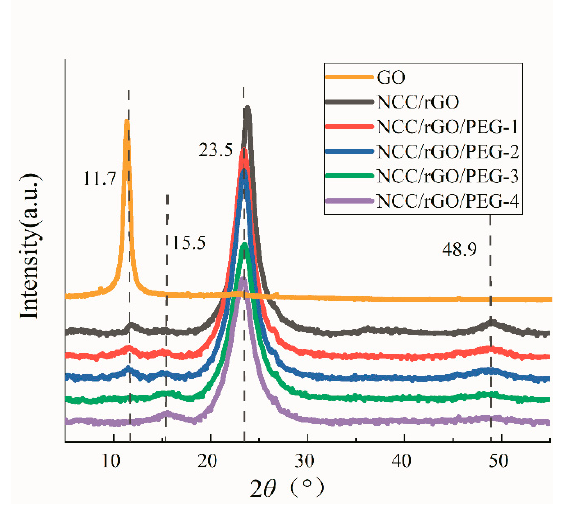
Figure 4. X-ray diffraction(XRD) spectrum of GO and the composite film.